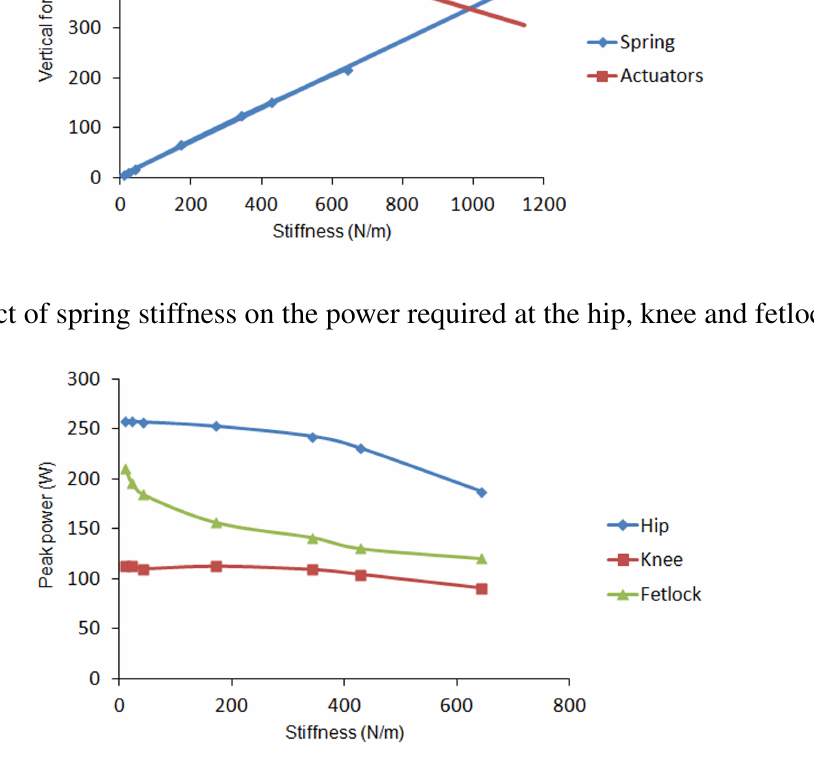
Figure 10. Effect of spring stiffness on the duration of the support